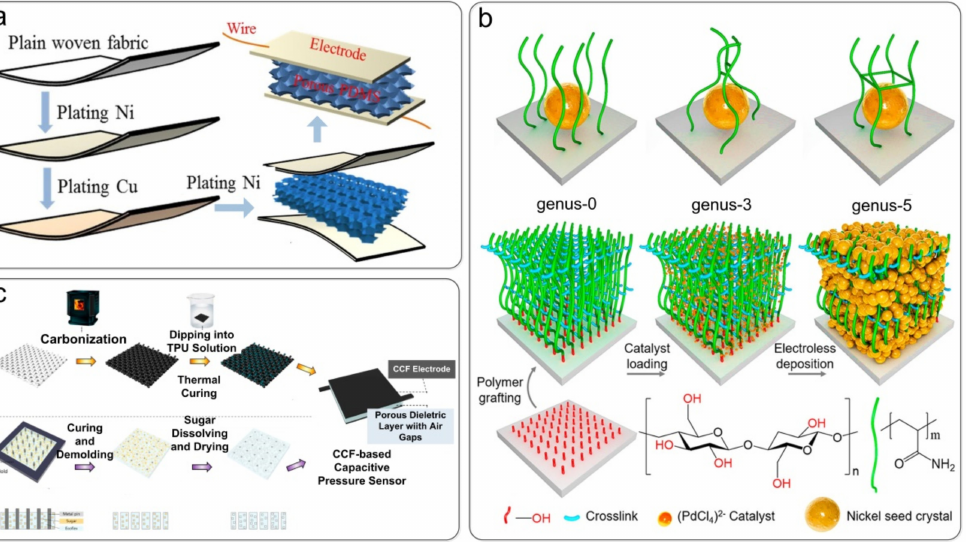
Figure 5. Fabric substrate is modified to prepare a capacitive pressure sensor. ( a ) Conductive fabric electrodes electroplated with nickel and copper. Reproduced with permission from Ref. [10]. Copy- right 2020 Elsevier. ( b ) Preparation of cotton fibers with a uniform coating of conductive materials using a topology modification method. Reproduced with permission from Ref. [131]. Copyright 2020 American Chemical Society. ( c ) Preparation of a fabric capacitance sensor by combining a carbonized cotton fabric electrode with an Ecoflex dielectric layer. Reproduced with permission from Ref. [103]. Copyright 2021